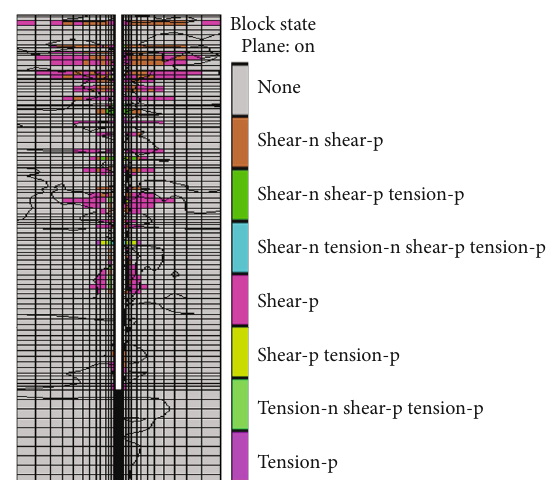
Figure 11: Shaft surrounding rock displacement.